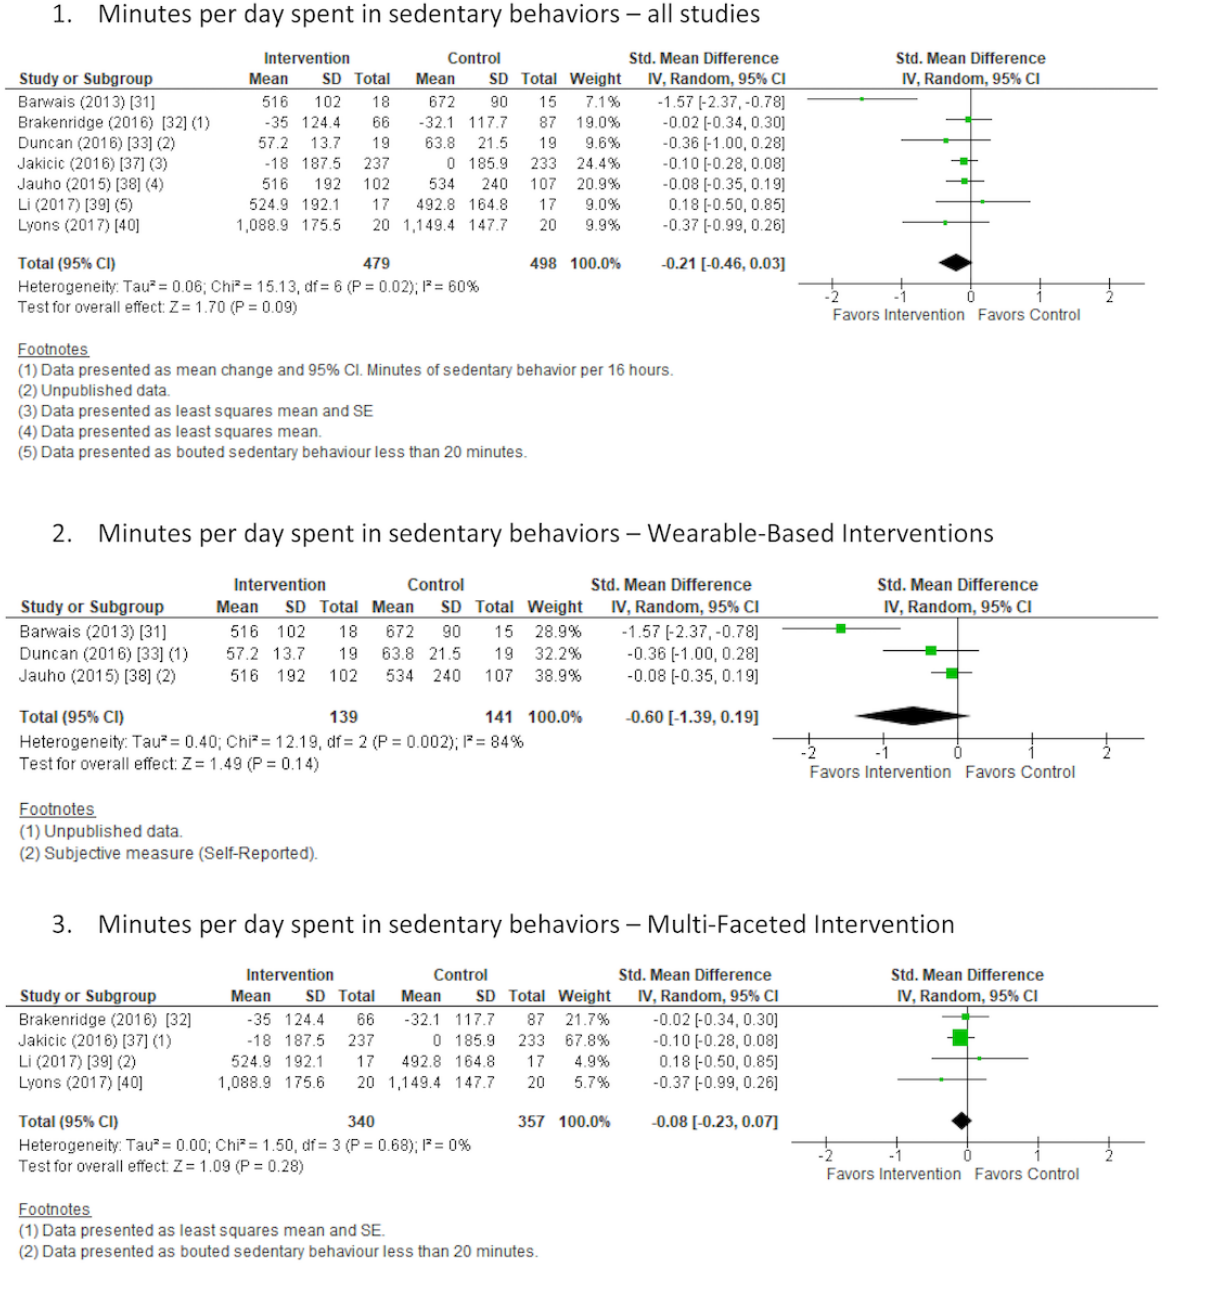
Figure 6. Forest plot of standardized mean difference of time spent in sedentary behaviors in studies comparing an intervention that included a consumer-based wearable activity tracker with a control group that did not utilize a consumer-based wearable activity tracker. Subgroup analysis was completed on studies that included wearable-based interventions compared with control and multifaceted interventions compared with control. Green square indicates the standardized mean difference for each individual study. Black square indicates the overall standardized mean difference for all